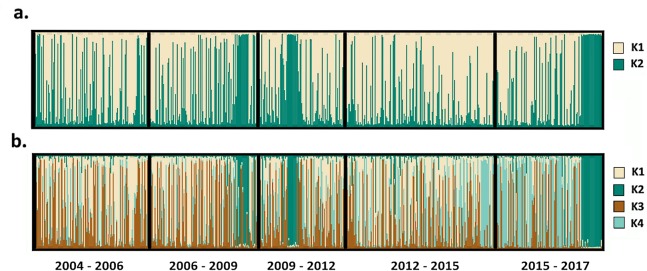
Temporal trends in the prevalence of P. falciparum sub-populations.STRUCTURE bar plots illustrating the distribution of P. falciparum isolates with ancestry to the given K sub-populations over time. Panel a) presents the data assuming K = 2, and panel b) presents the data assuming K = 4. Each vertical bar presents a single isolate, whose relative ancestry to each of the given K sub-populations is illustrated by the proportionate colour-coded segments. Isolates are ordered from left to right on the x-axis by date of collection (oldest to most recent). At K = 2, each temporal period exhibits an approximate 3:2 ratio composition of isolates with predominant ancestry (>85%) to K1 and K2 respectively. At K = 4, majority of isolates in the first two temporal periods have predominant ancestry to K1 or K3, whilst the majority in the later periods have predominant ancestry to K2 or K4. Isolates with predominant ancestry to K2 prevail in late 2016 and throughout 2017.